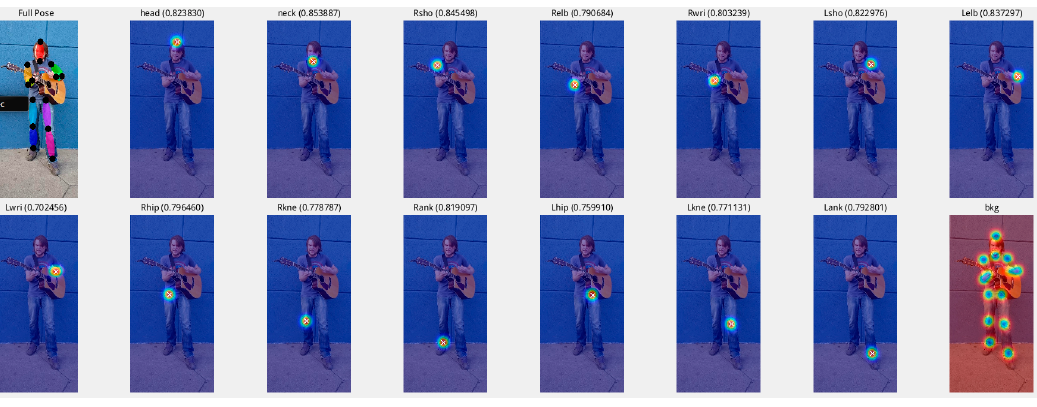
Figure 7. The 14 key points. Table 7. The accuracy of the nine models.